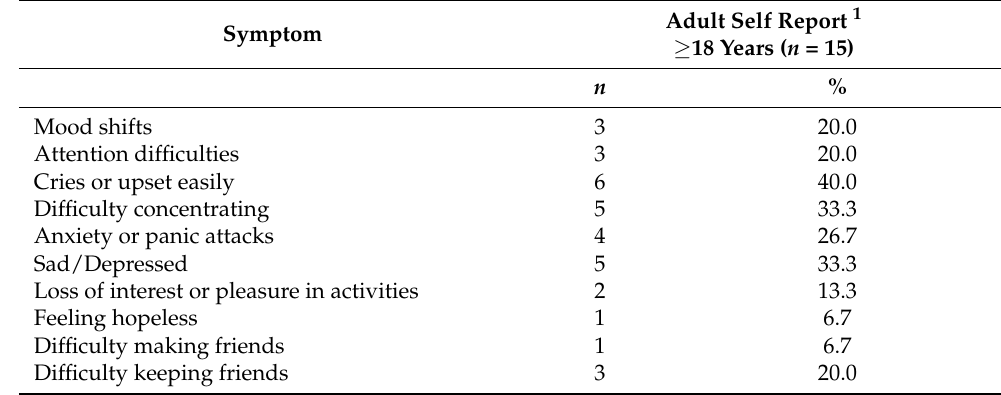
Table 2. Adult self-report of psychosocial symptoms.